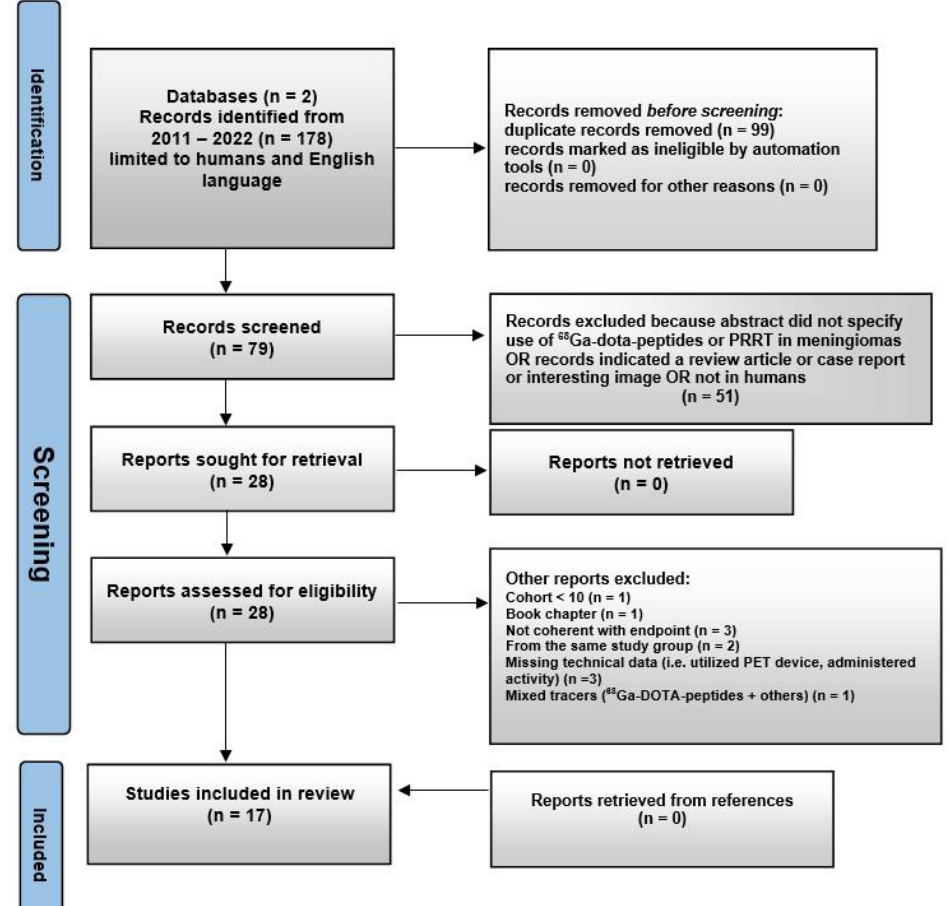
Figure 1. Schematic representation of PRISMA workflow for manuscripts’ selection.